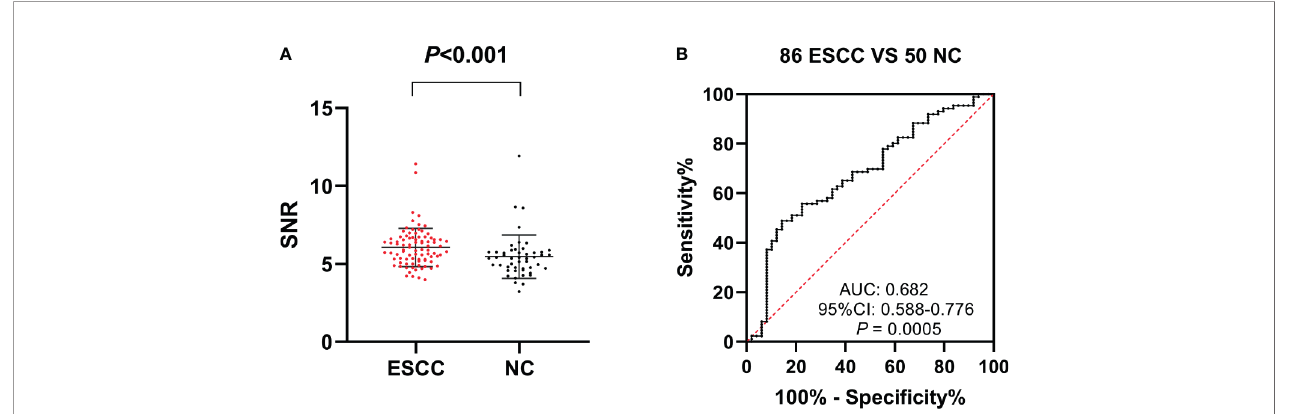
FIGURE 2 | The expression level and diagnostic value of anti-GNA11 autoantibody in ESCC patients and normal controls in screening phase. (A) The scatter plot depicts the level of anti-GNA11 autoantibody in ESCC group and normal control group. (B) The receiver operating characteristic curve of anti-GNA11 autoantibody in the screening stage. ESCC, esophageal squamous cell carcinoma; NC, normal controls; SNR, signal-to-noise